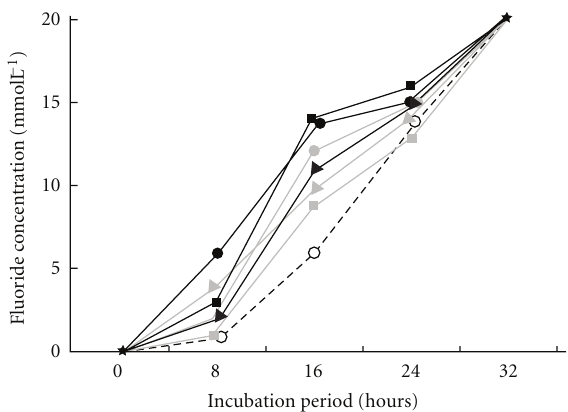
Figure 2: Sodium fluoroacetate degradation rate by bacteria isolated from both soil and plants in the State of Para´ıba, Brazil. Symbols are as follows. The white circle: ECPB01; the black triangle: ECPB02; the black square: ECPB03; the grey circle: ECPB04; the grey square: ECPB05; the grey triangle: ECPB06; the black circle: